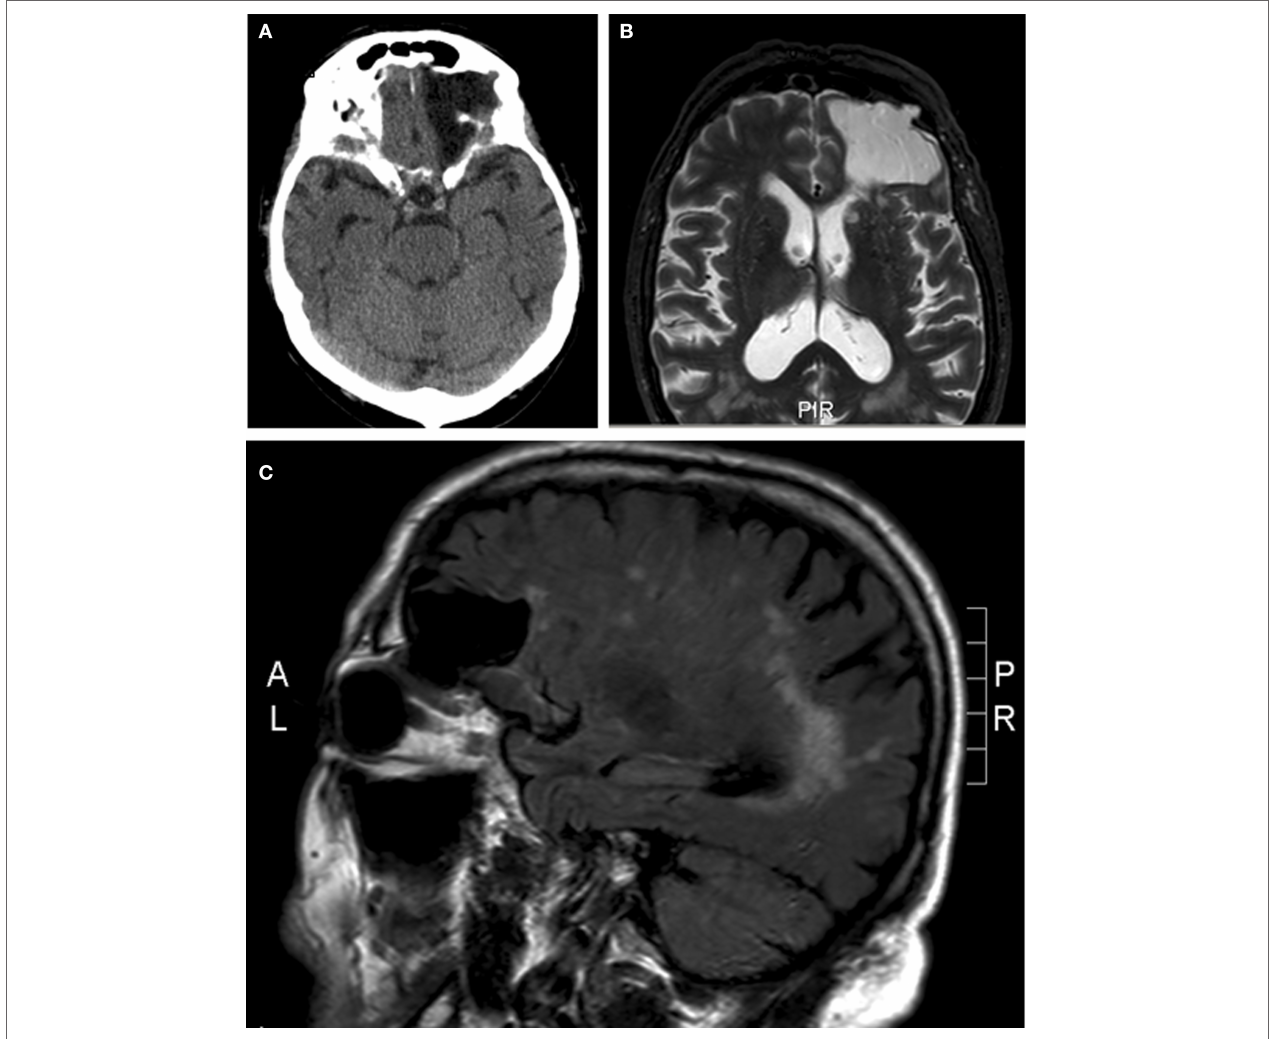
FIGURe 1 | Meningocele into the left orbit due to a bony defect in the orbital roof. (a) Axial computed tomography. (B) Axial magnetic resonance imaging short T1 inversion recovery sequence. (C) Sagittal magnetic resonance imaging, fluid-attenuated inversion recovery sequence.